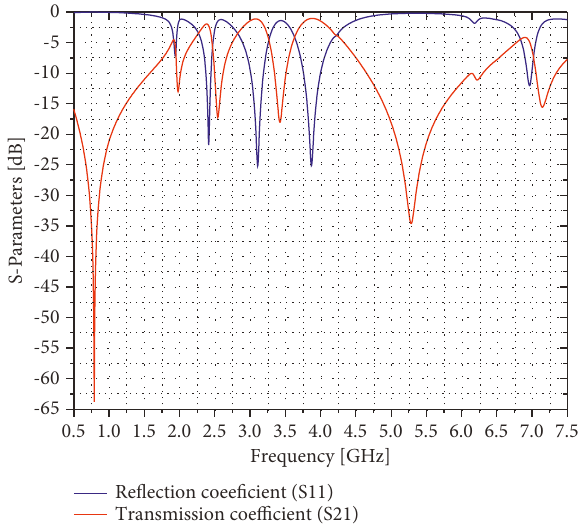
Figure 6: Scattering parameters of the DSCSRR.